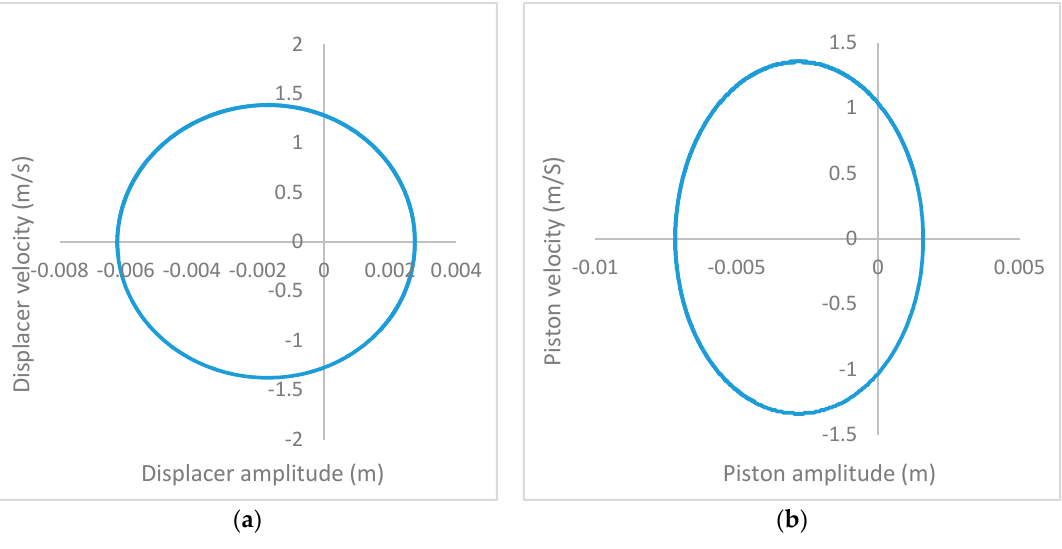
Figure 9. ( a ) Displacer velocity against displacer amplitude; ( b ) Piston velocity against piston amplitude.